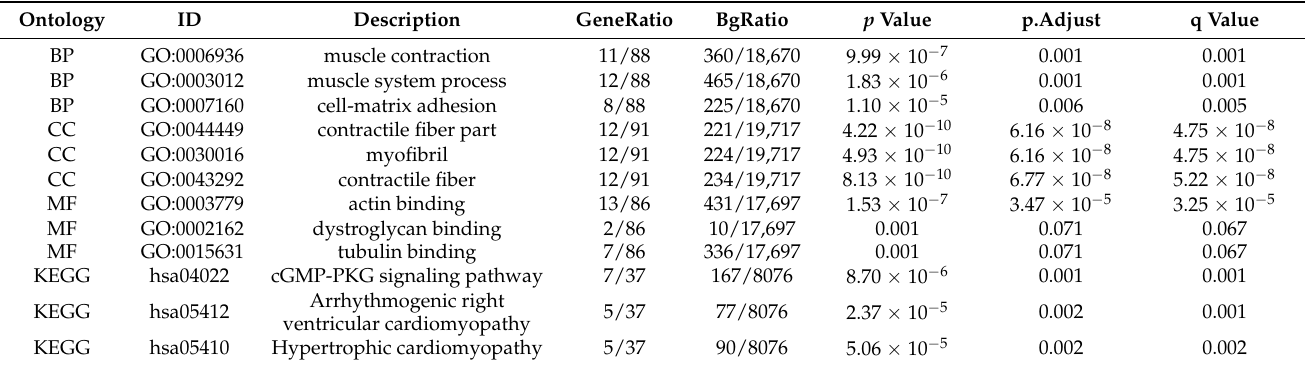
Figure 4. The top 100 genes co-expressed with SEC23A were selected to conduct an enrichment analysis. The results of GO biological process (BP) analysis, GO term cellular component (CC) analysis, molecular function (MF) and KEGG analysis are shown in ( A ). The association between SEC23A and the top 5 co-expressed genes ( B ). Table 2. Enrichment analysis of the top 100 genes co-expressed with SEC23A in